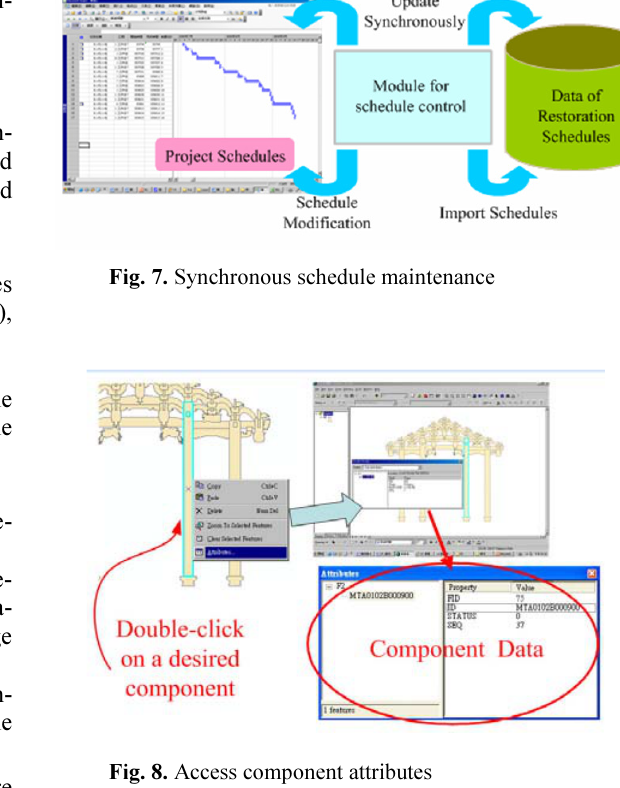
Fig. 8. Access component